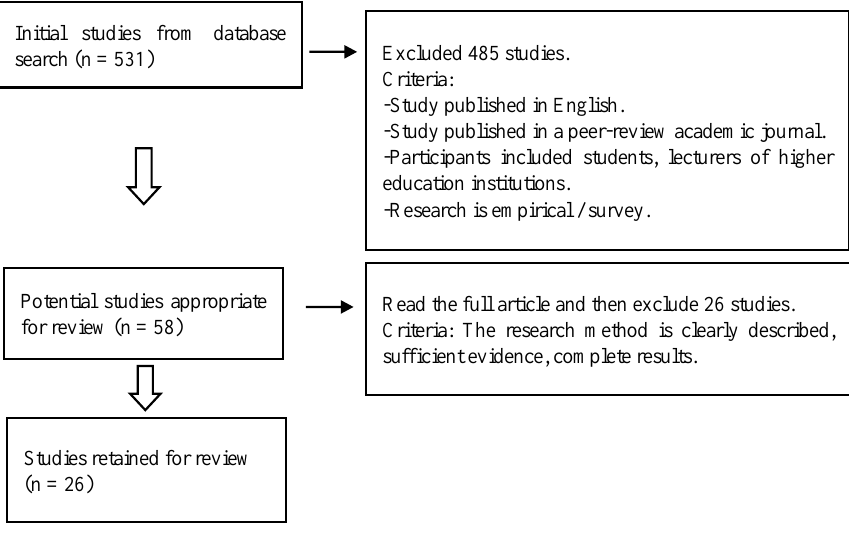
Fig. 1. Diagram of the screening